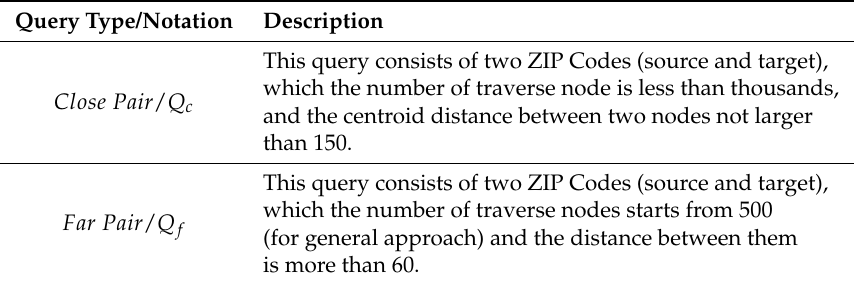
Table 5. Query types based on distance.